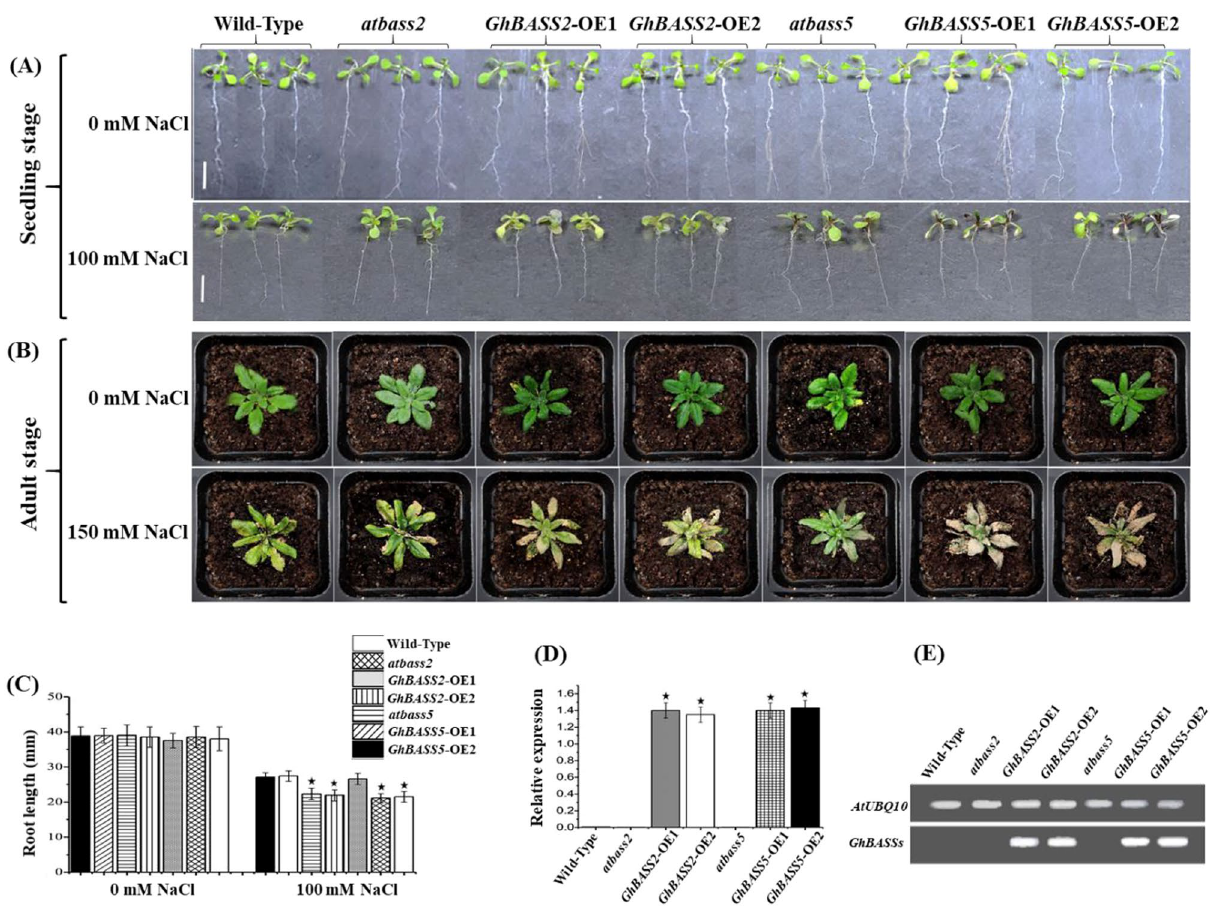
Figure 11. Constitutively overexpressing GhBASS2 and GhBASS5 weaken salt stress resistance in transgenic Arabidopsis . ( A ) The seedling’s phenotypes of transgenic OE lines, wild-type and loss-of-function mutants growing on the 1/2 MS medium supplemented with 0 or 100 mM NaCl for ten days. Bar = 10 mm. ( B ) The adult’s phenotypes of transgenic OE lines, wild-type and loss-of-function mutants after a seven-day treatment with 0 or 150 mM NaCl. ( C ) Root length of the wild-type, mutants and OE seedlings treated with 0 or 100 mM NaCl. ( D , E ) Transcript levels of GhBASS2 and GhBASS5 in wild-type, mutants and OE plants by qPCR and RT-PCR. The AtUBQ10 gene (GenBank accession no. AT4G05320) was used as an internal standard. Means and standard deviations were based on three independent biological replicates. Error bars represent the variation among three independent biological replications. Asterisks indicate the significant difference ( * , P = 0.05) from WT by Tukey’s HSD